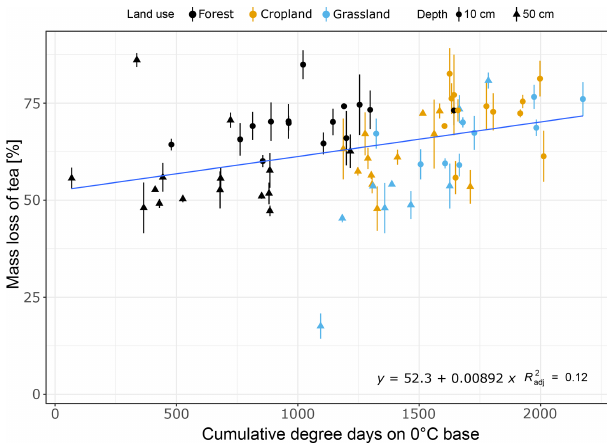
Figure 7. Point range and regression line ( p< 0 . 05) of tea decom- position over cumulative degree days at 10cm depth (circles) and 50cm depth (triangles). Shapes indicate mean values; vertical lines indicate standard deviation of the decomposition. The regression line was fitted using all data points.